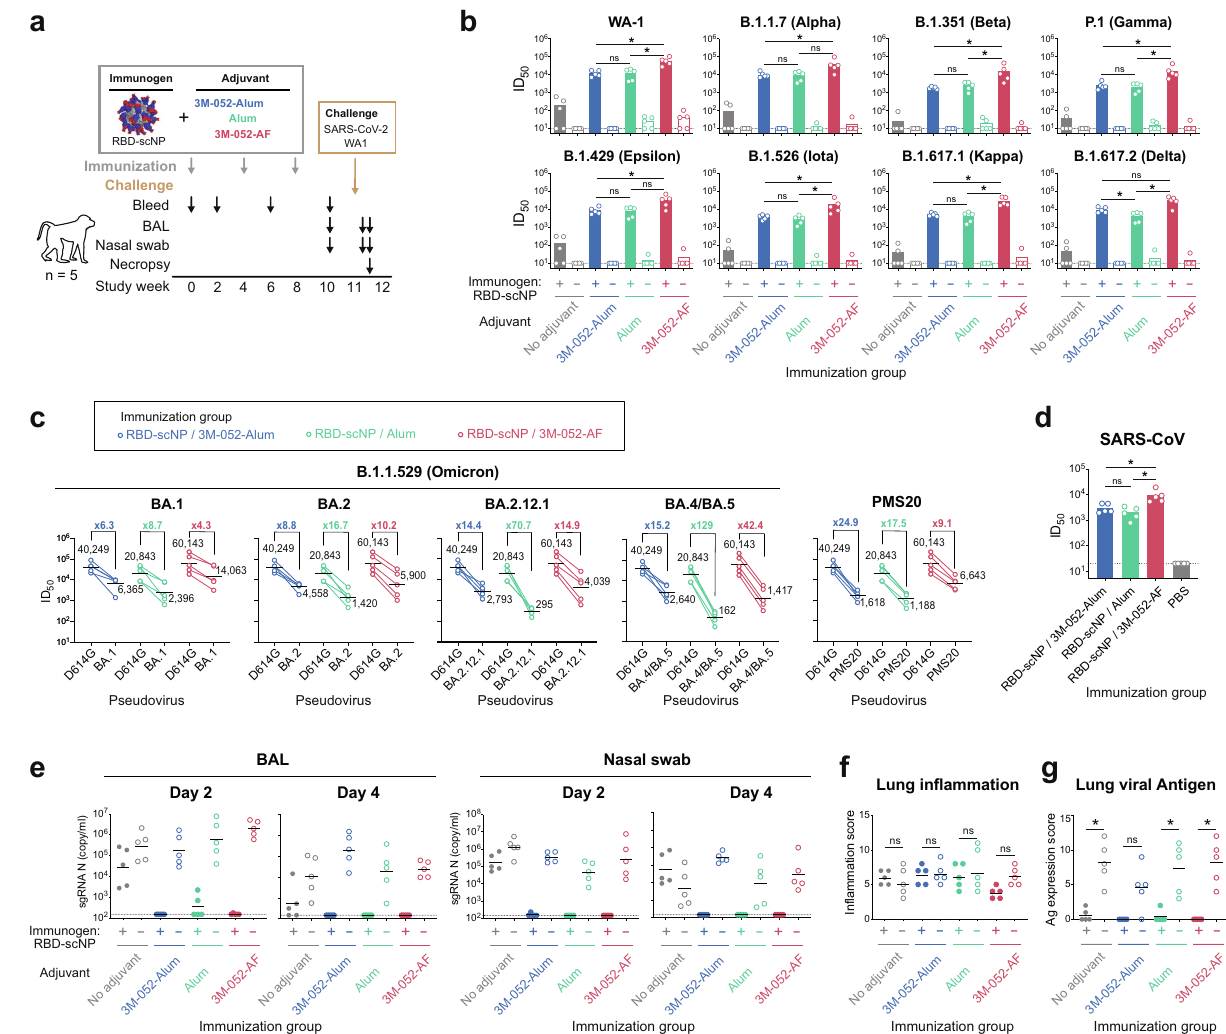
Fig. 1 | Neutralizing antibodies and in vivo protection elicited by RBD-scNP vaccine formulated with three different adjuvants. a Schematic of the vaccina- tionandchallengestudy.Cynomolgusmacaques( n =5pergroup)wereimmunized intramuscularly 3 times with 100 μ g of RBD-scNP adjuvanted with 3M-052-Alum, Alum,3M052-AF,orPBScontrol. Animalsinjected withadjuvant aloneorPBSwere set as control groups. Monkeys were then challenged with SARS-CoV-2 WA-1, subjected to blood, Bronchoalveolar lavage (BAL) and nasal swab collection, and necropsied for pathologic analysis. b Neutralization titers (ID 50 ) of plasma anti- bodies against pseudovirus of SARS-CoV-2 variants in 293T-ACE2-TMPRSS2. Each dot indicates one monkey ( n =5 per group) and bars indicate geometric mean values of each group. Adjusted p -values: ns, not signi fi cant, * p <0.05, two-sided Wilcoxon rank sum exact test. c Serum antibody neutralization against pseudo- viruses of the SARS-CoV-2 Omicron (BA.1, BA.2, BA.2.12.1, BA.4/BA.5) variants, and SARS-CoV-2 PMS20 variant in 293T-ACE2 cells. The geometric mean titers and the